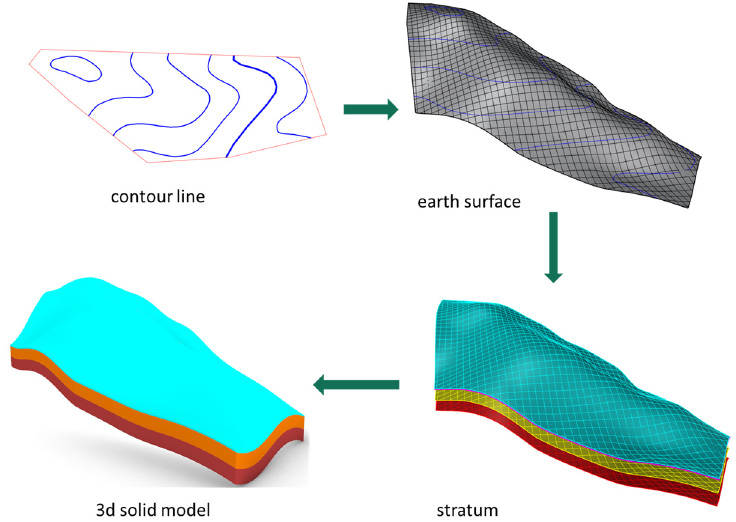
Figure 5. Modeling process of the test stope.